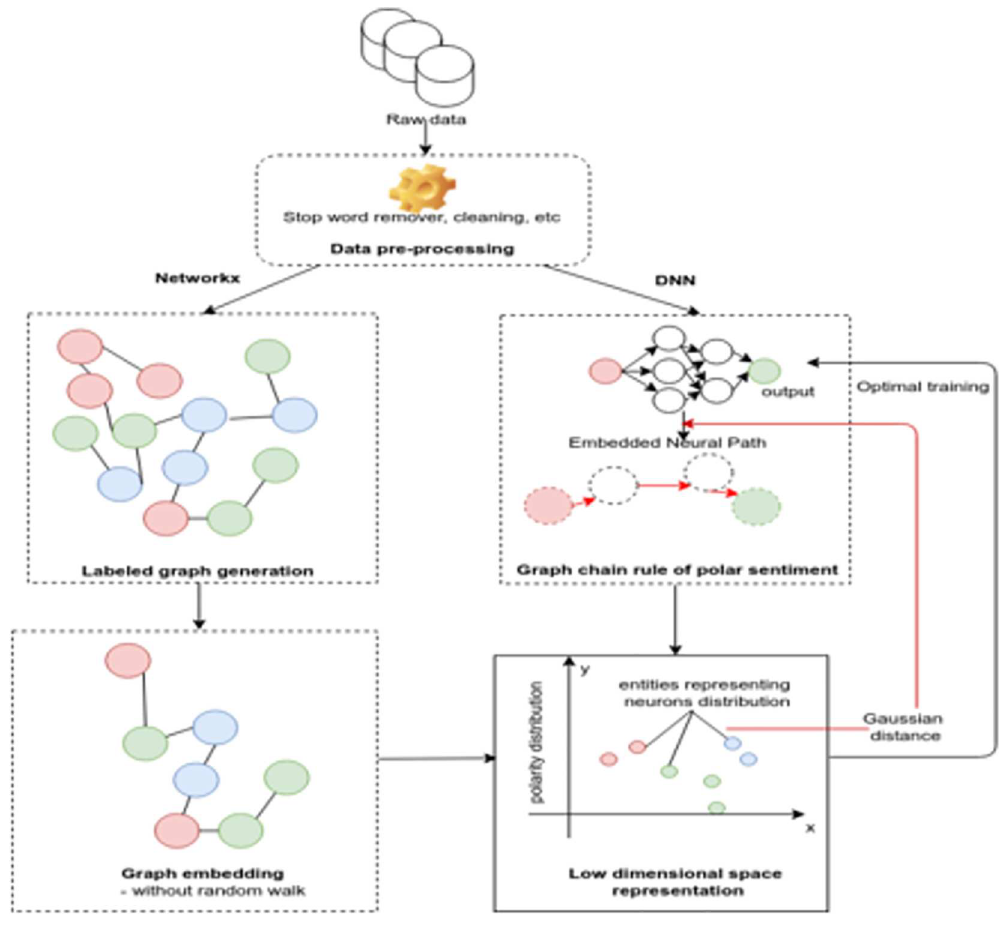
Fig 14. “evcerydayhealth”